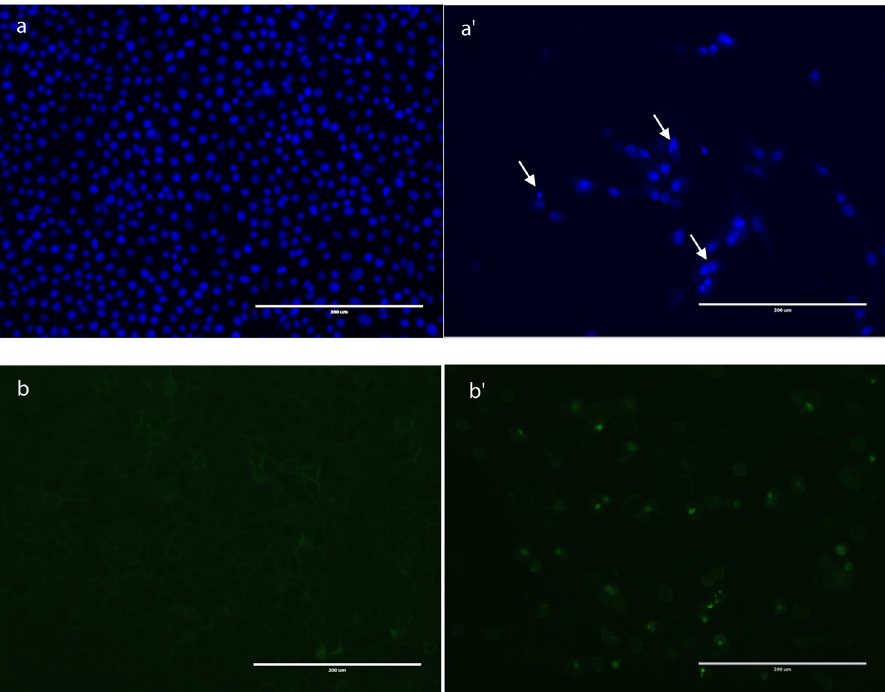
Figure 2: Induction of apoptosis in HepG2 cells by treatment with hexane propolis extract for 48 h. ( a ) Apoptosis as assessed by nuclear staining. Cells treated with 0.1% methanol vehicle displayed even nuclear staining ( a ) . HepG2 cells showing condensation of DNA ( a ′ ) . The white arrows show apoptotic cells. ( b ) control cells, ( b ′ ) treated